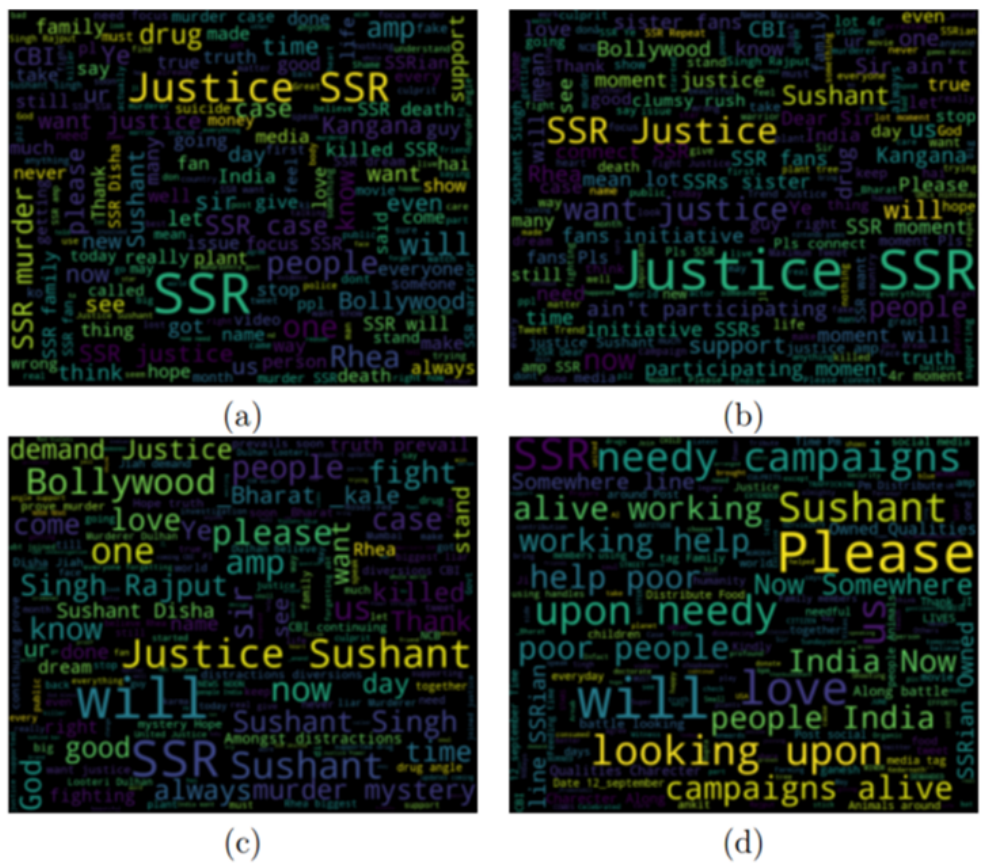
Figure 8. Word cloud using the ( a ) #SSR, ( b ) #JusticeForSSR, ( c ) #WorldUnited4SSR, and ( d ) #Food4SSR. The subjectivity vs. polarity graph is depicted in Figure 9. for #SSR and